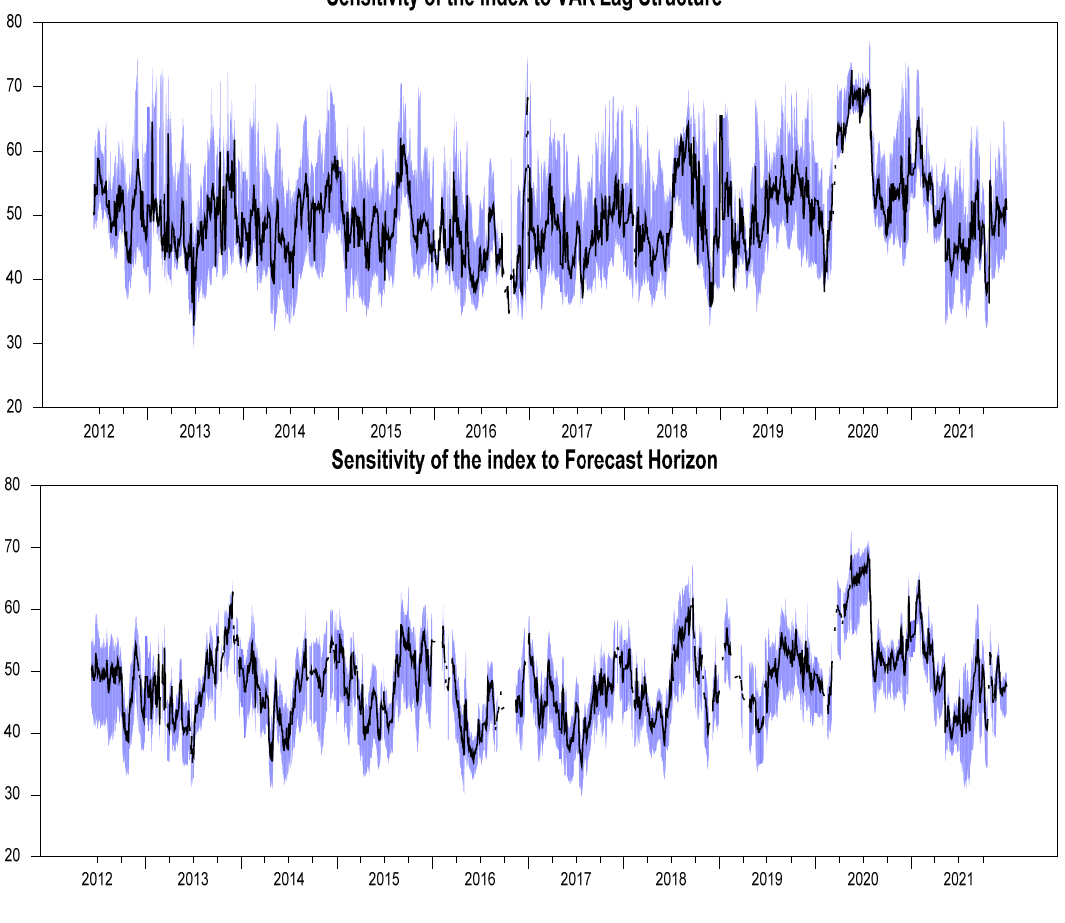
Figure 11. Robustness of results.